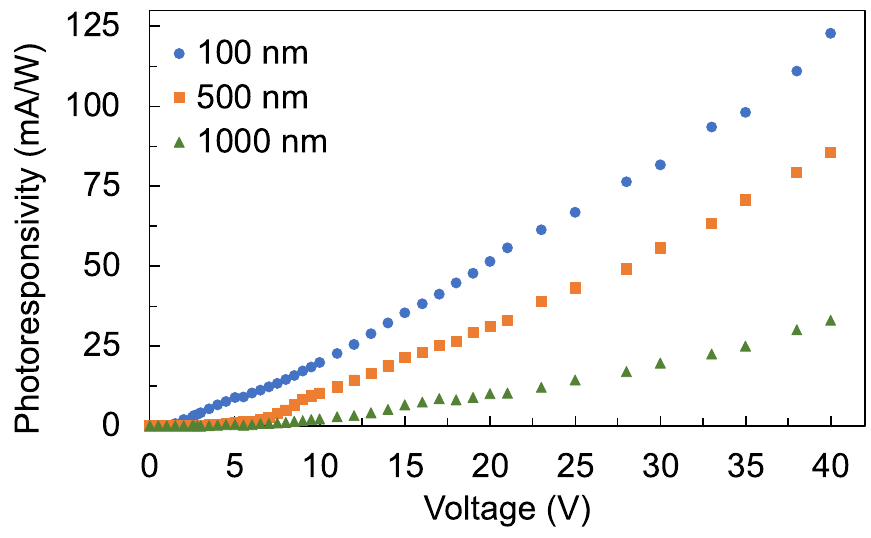
Figure 9. Photoresponsivity of the detectors with 100 nm, 500 nm, and 1000 nm film thicknesses. The wavelength response of the TiO 2 thin-film detectors measured at a fixed bias voltage of 40 V is shown in Figure 10. The intensity of the excitation source is not flat across the wavelengths considered (200 nm to 400 nm) because the monochromator efficiency and excitation lamp emissivity changes as a function of wavelength. Therefore, the measured photocurrent was normalized by the measured power of the excitation source for each wavelength considered. The cut-off wavelengths of the detectors with 100 nm, 500 nm, and 1000 nm film thicknesses are 320 nm, 330 nm, and 345 nm, respectively. The detector will not be responsive to wavelengths that are longer than the cut-off wavelength. The cut-off wavelength of the detector is observed to shift to longer wavelengths as the thickness of the film increases. This shift is consistent with the observed red shift in the transmission and absorption edges as well as the decrease in the band-gap energy as the film becomes thicker. These results suggest that the thickness of the film may be controlled to manipulate the wavelength response of the detectors to filter out unwanted longer wavelengths, especially if the trade-off in photoconductivity is acceptable for that specific application.